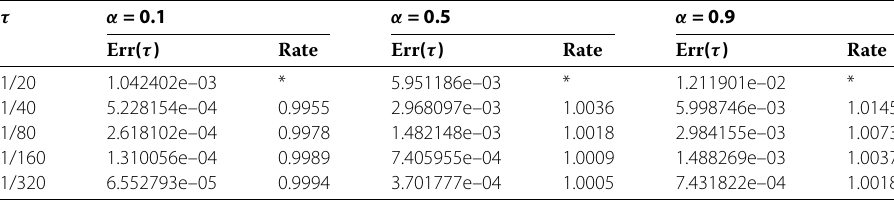
Table 1 Numerical errors and convergent orders with λ = 2, T = 1, when q = 1 τ α = 0.1 α =